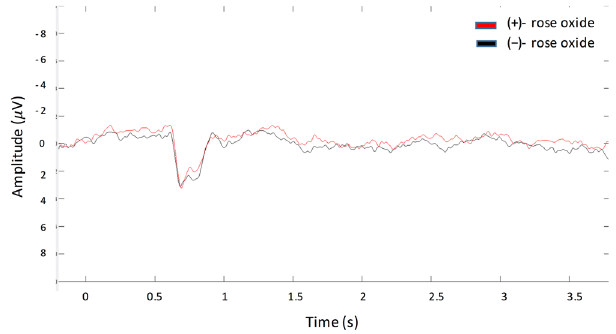
Figure 5. Grand average of OERP in response to ( + )-rose oxide (red line) and ( − )-rose oxide (black